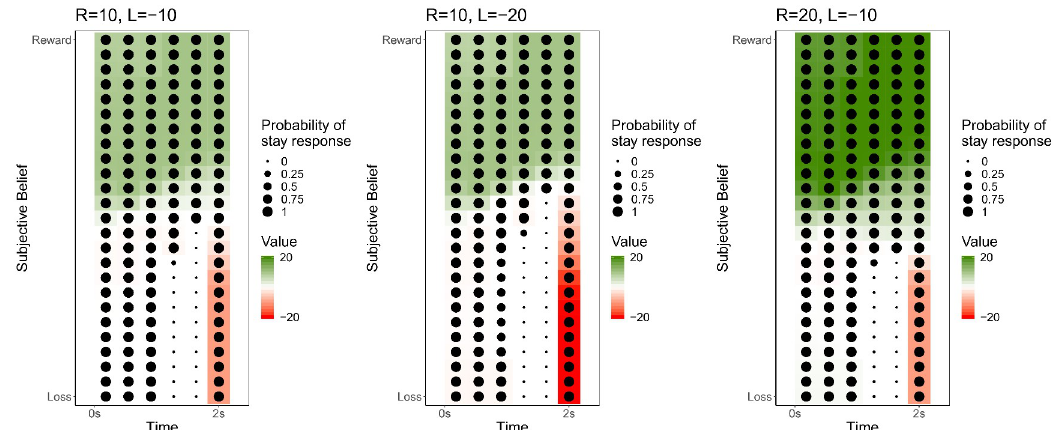
Fig 7. State values. Heatmap illustrating the value of occupying each state as the value of the offered reward and threatened loss varies. The state values earlier in the trial in which there is a weaker belief that the trial will be rewarded (i.e., bottom left quadrant of each heatmap), are close to zero; this reflects that the ‘go’ action is the most likely future action and hence the trial outcome will most likely be zero. The value of states representing no strong belief changes across time (i.e., middle third of the y-axis on each heatmap); this reflects that transitions to a state with a high value (e.g., resulting from a strong certainty of reward) may be considered probable earlier in time, but if there is uncertainty about the stimulus further into the trial, then it is most likely that the stimulus has a low coherence and that reaching a high value state is less probable. The overall value of states representing no strong belief about the stimulus are most strongly modulated by the subjective value of the reward and loss; being higher when the reward is higher, and lower when the loss is